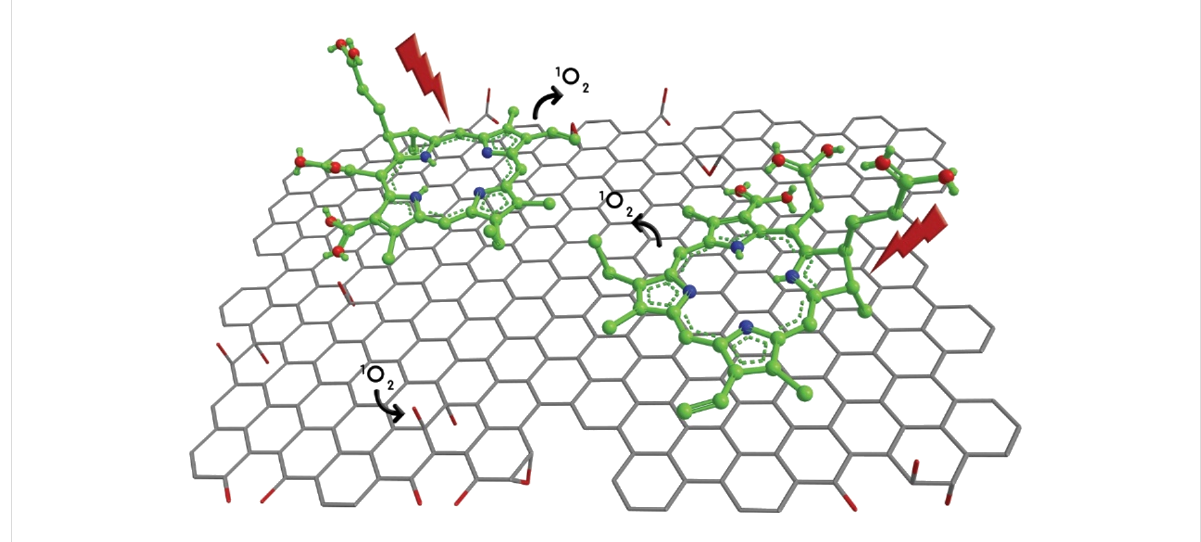
Figure 2: Schematic representation of the FLG-Ce6 hybrid nanomaterial. Ce6 molecules (green) stabilize a graphene sheet in water. FLG acts as an electron donor for the Ce6 molecules, enhancing its capability as a photosensitizer. The interaction of Ce6 molecules with the graphene sheet